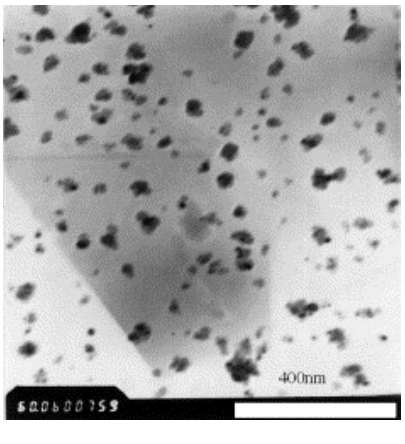
Figure 4. TEM image of TiO Copyright 2005